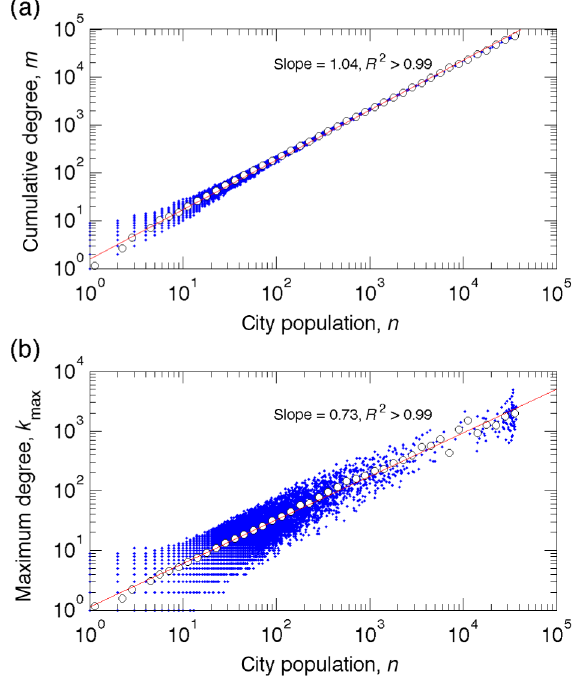
FIG. 6 (color online). Scatter plot of (a) the cumulative degree of all nodes and (b) the degree of the most connected nodes as a function of the city size, respectively. In (a) the average cumulative degree ( ∘ ) follows a superlinear power-law scaling (solid line), h m ð n Þi ∼ n y , with an estimated exponent in [1.03,1.05] (95% confidence interval). In (b) the average maxi- mum degree ( ∘ ) follows a sublinear power-law scaling (solid line), with an estimated exponent in [0.72,0.75] (95% confidence interval), consistent with the theoretical prediction of h k ð n Þi ∼ n 1 = ð γ − 1 Þ , where γ ≈ 2 . 3 for r ¼ 0 . 8 . The leveling max off of the curve towards larger n is explained by the effect of merging